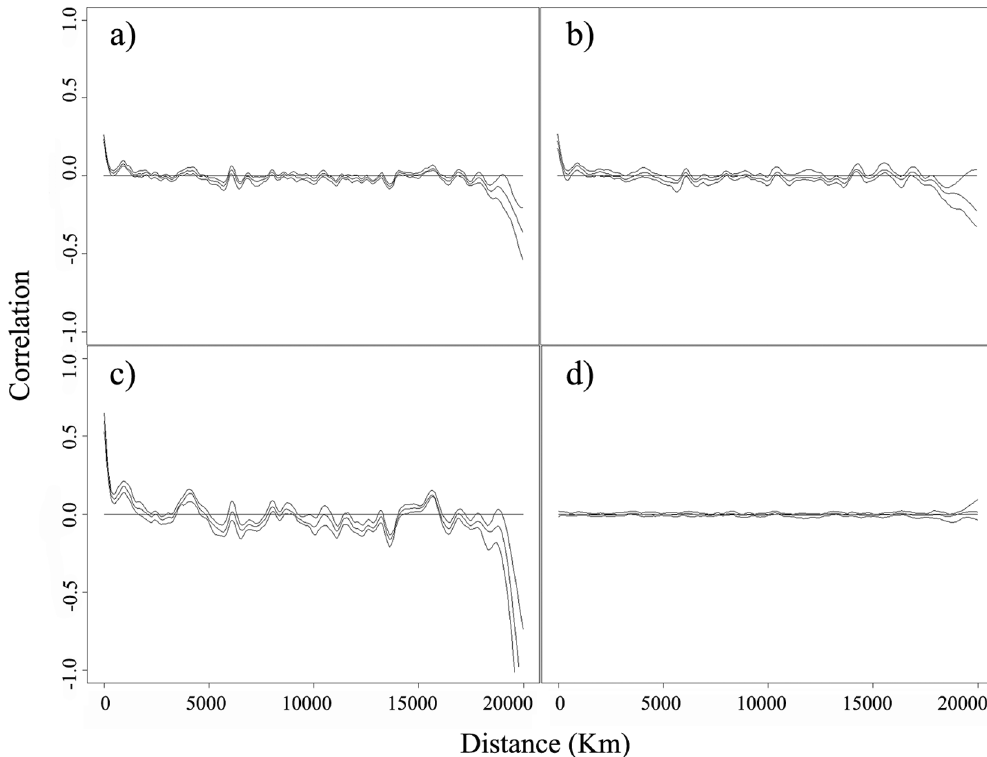
Fig 1. Correlograms of global amphibian chytrid fungus ( Batrachochytrium dendrobatidis ) data. Batrachochytrium dendrobatidis correlograms indicate positive spatial autocorrelation in chytrid presence between sampled sites: a) in full dataset; b) 50% sampled training data; c) predictions generated by the random forest model. However, spatial autocorrelation is absent in residuals from the random forest model